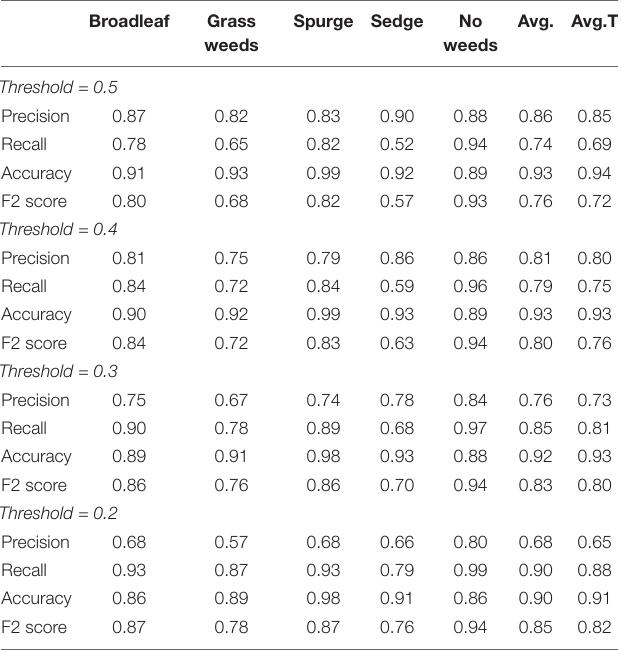
TABLE 2 | Validation results of a multiple-class neural network trained on six surveys using architectures ResNet 34 for detection of weed types in sod production